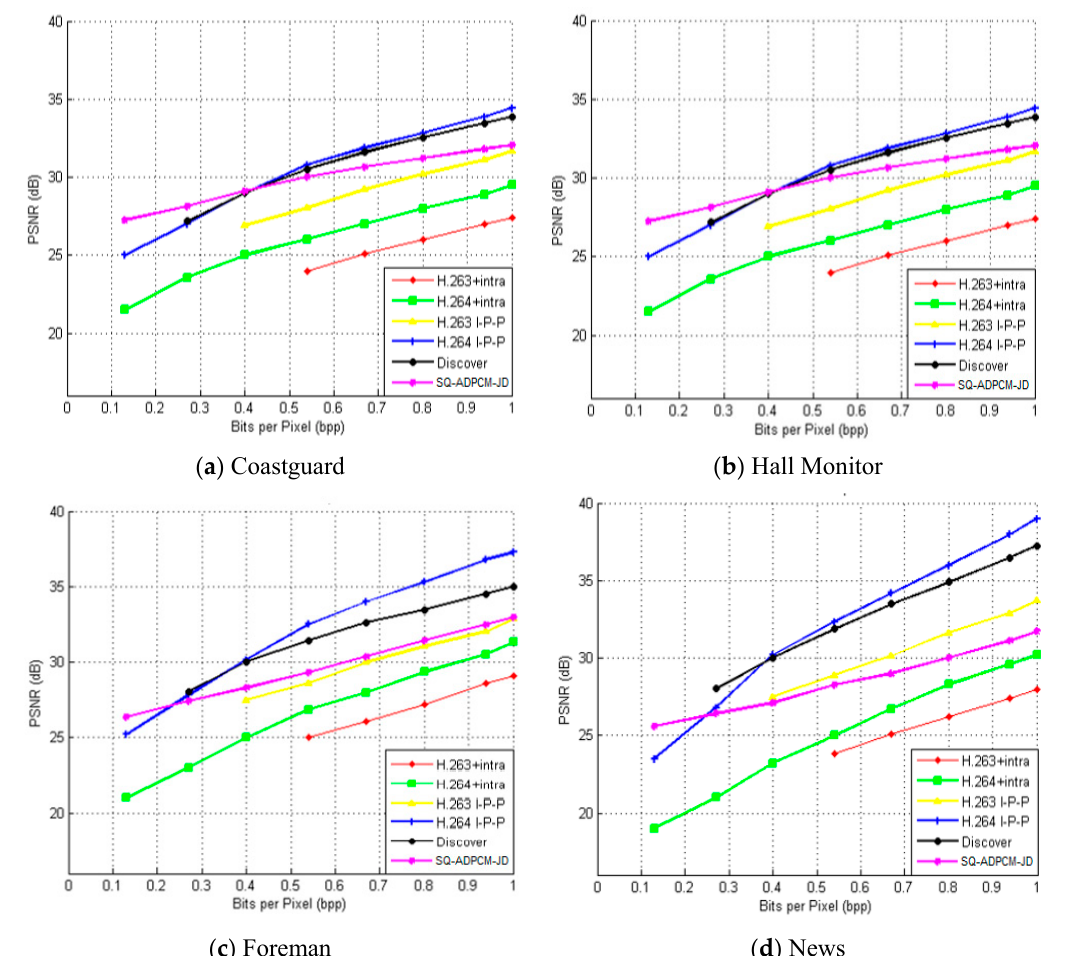
Figure 7. PSNR comparison of proposed SQ-ADPCM-JD with conventional codecs i.e., DISCOVER, H.264 (intra, (I-P-P)) and H.263 (intra, (I-P-P)) at various bitrate for different video sequences.